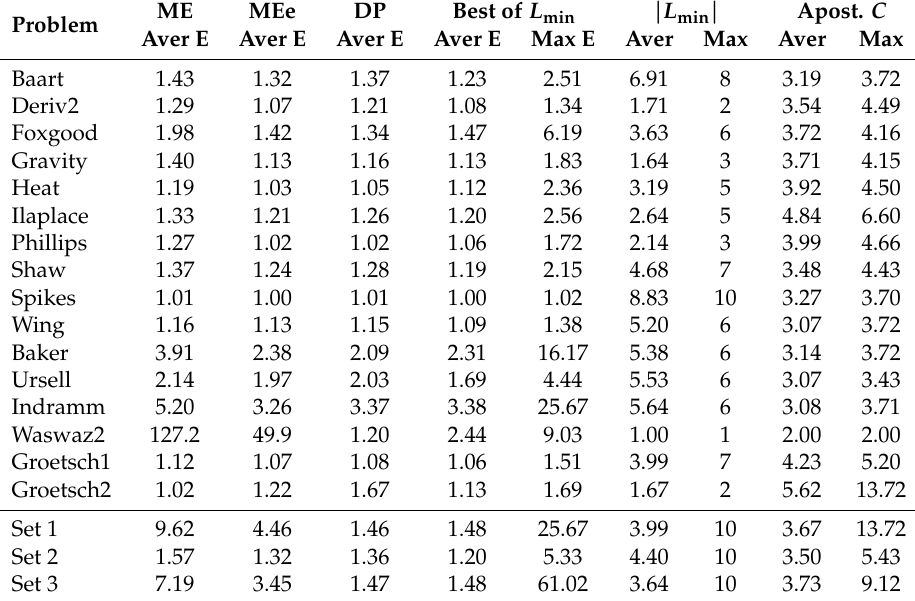
Table 3. Results for the set L min